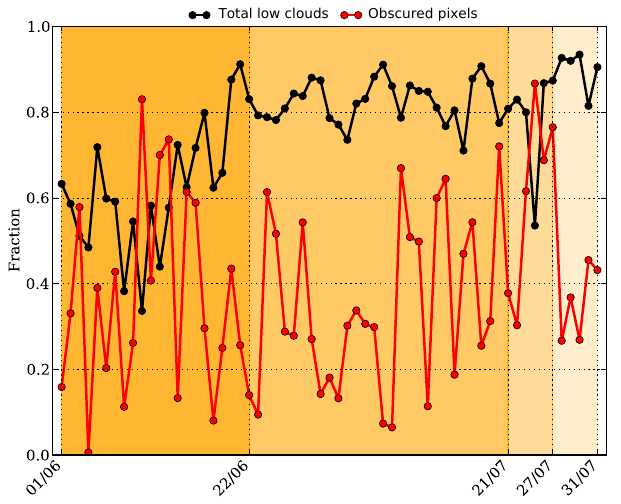
Figure 17. Time evolution of low-cloud fraction over the DAC- CIWA focus region (5–10 ◦ N, 8 ◦ W–8 ◦ E, land pixels only; see Fig. 1 for location) during June–July 2016. Depicted as a black line is the average fraction of pixels covered with low clouds (i.e. cloud- top pressure of 800hPa or higher). Pixels that are covered with ob- scuring mid- or high-level clouds (fraction given as red line) are dis- regarded, leading to a relatively large uncertainty in the low-cloud estimates on some days. Basis for this analysis is daily 00:00UTC CLAAS-2 images (see Sect. 2.1). The four phases of the DACCIWA campaign are marked with different orange